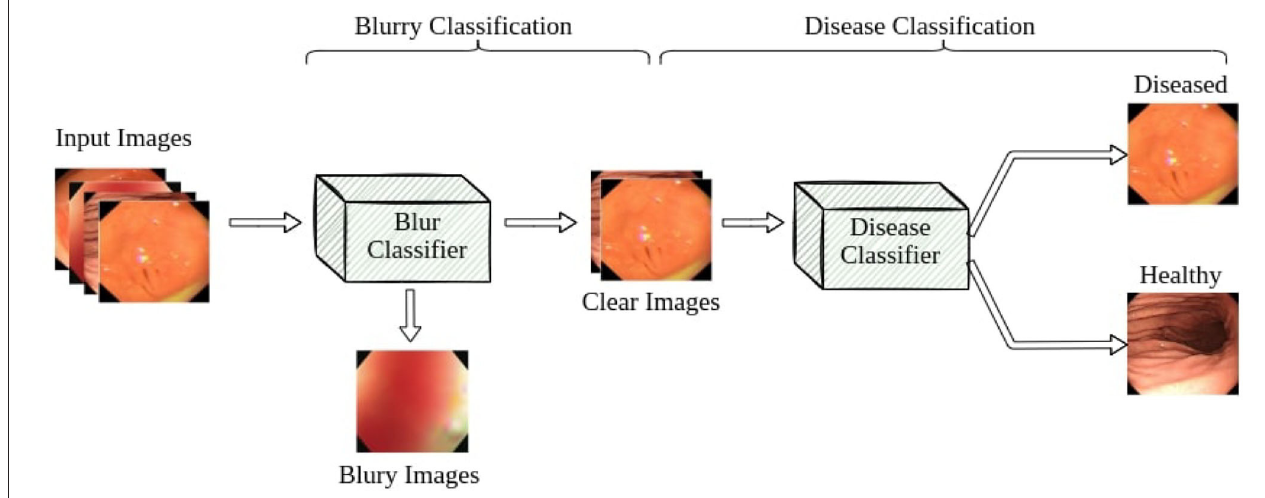
FIGURE 4 | Overview of our gastroscopic disease classification